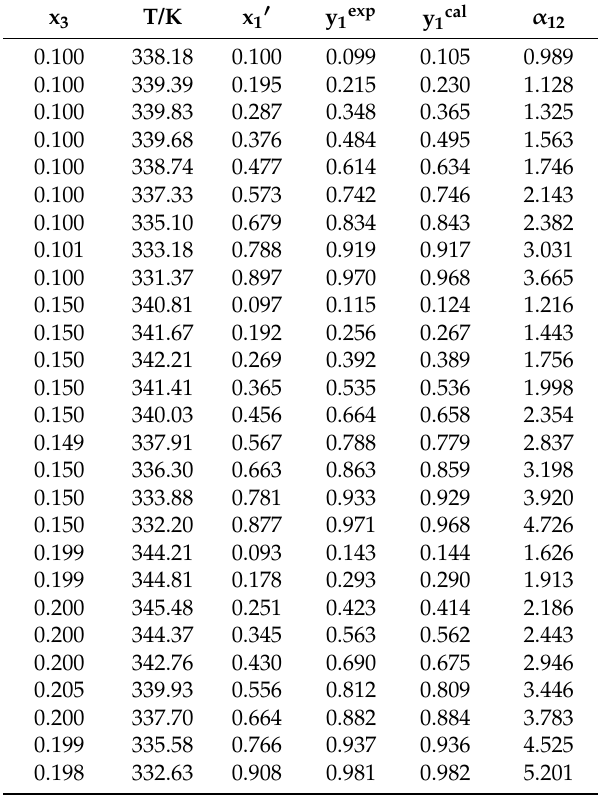
Table A3. VLE data for the ternary system of acetone (1) + chloroform (2) + [EMIM][DEP] (3) at 101.3